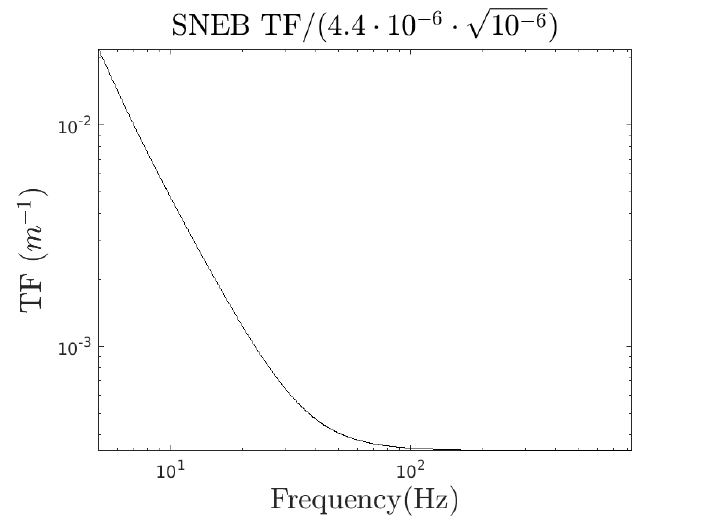
Figure 17. Transfer function from the cryobaffle displacement to the